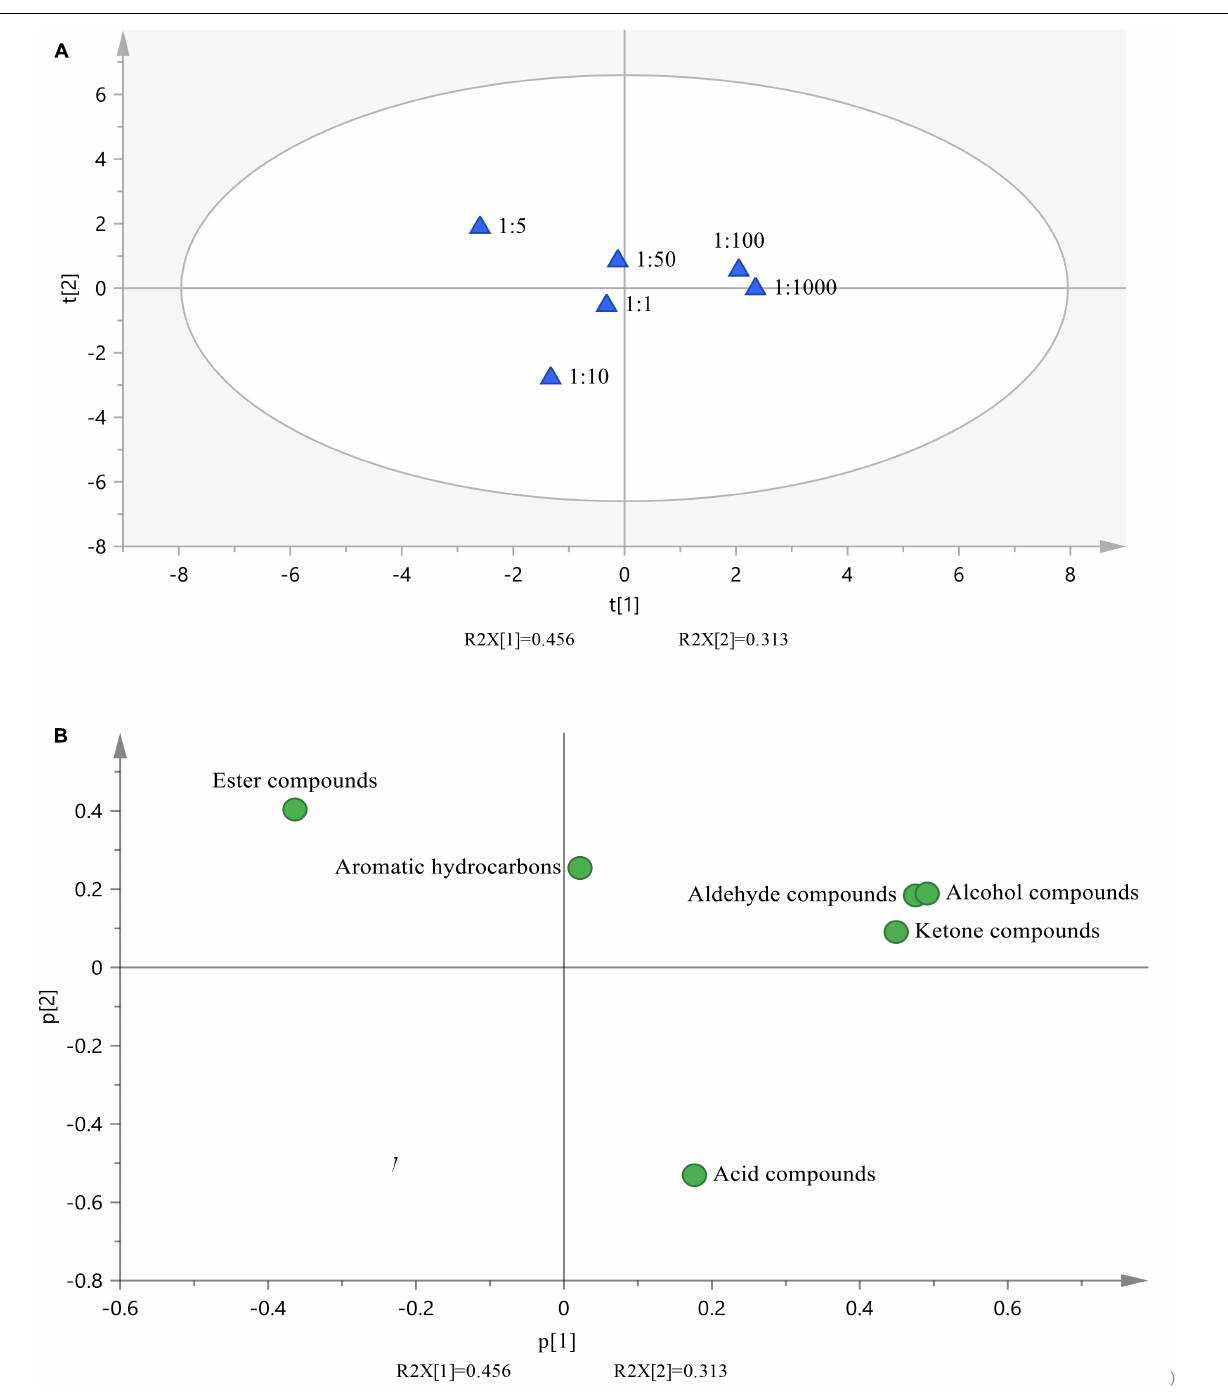
with L. plantarum P-8 to yogurt starter ratios of 1:100 were considered to have better yogurt characteristics than those of the other combinations, which were also considered to have good